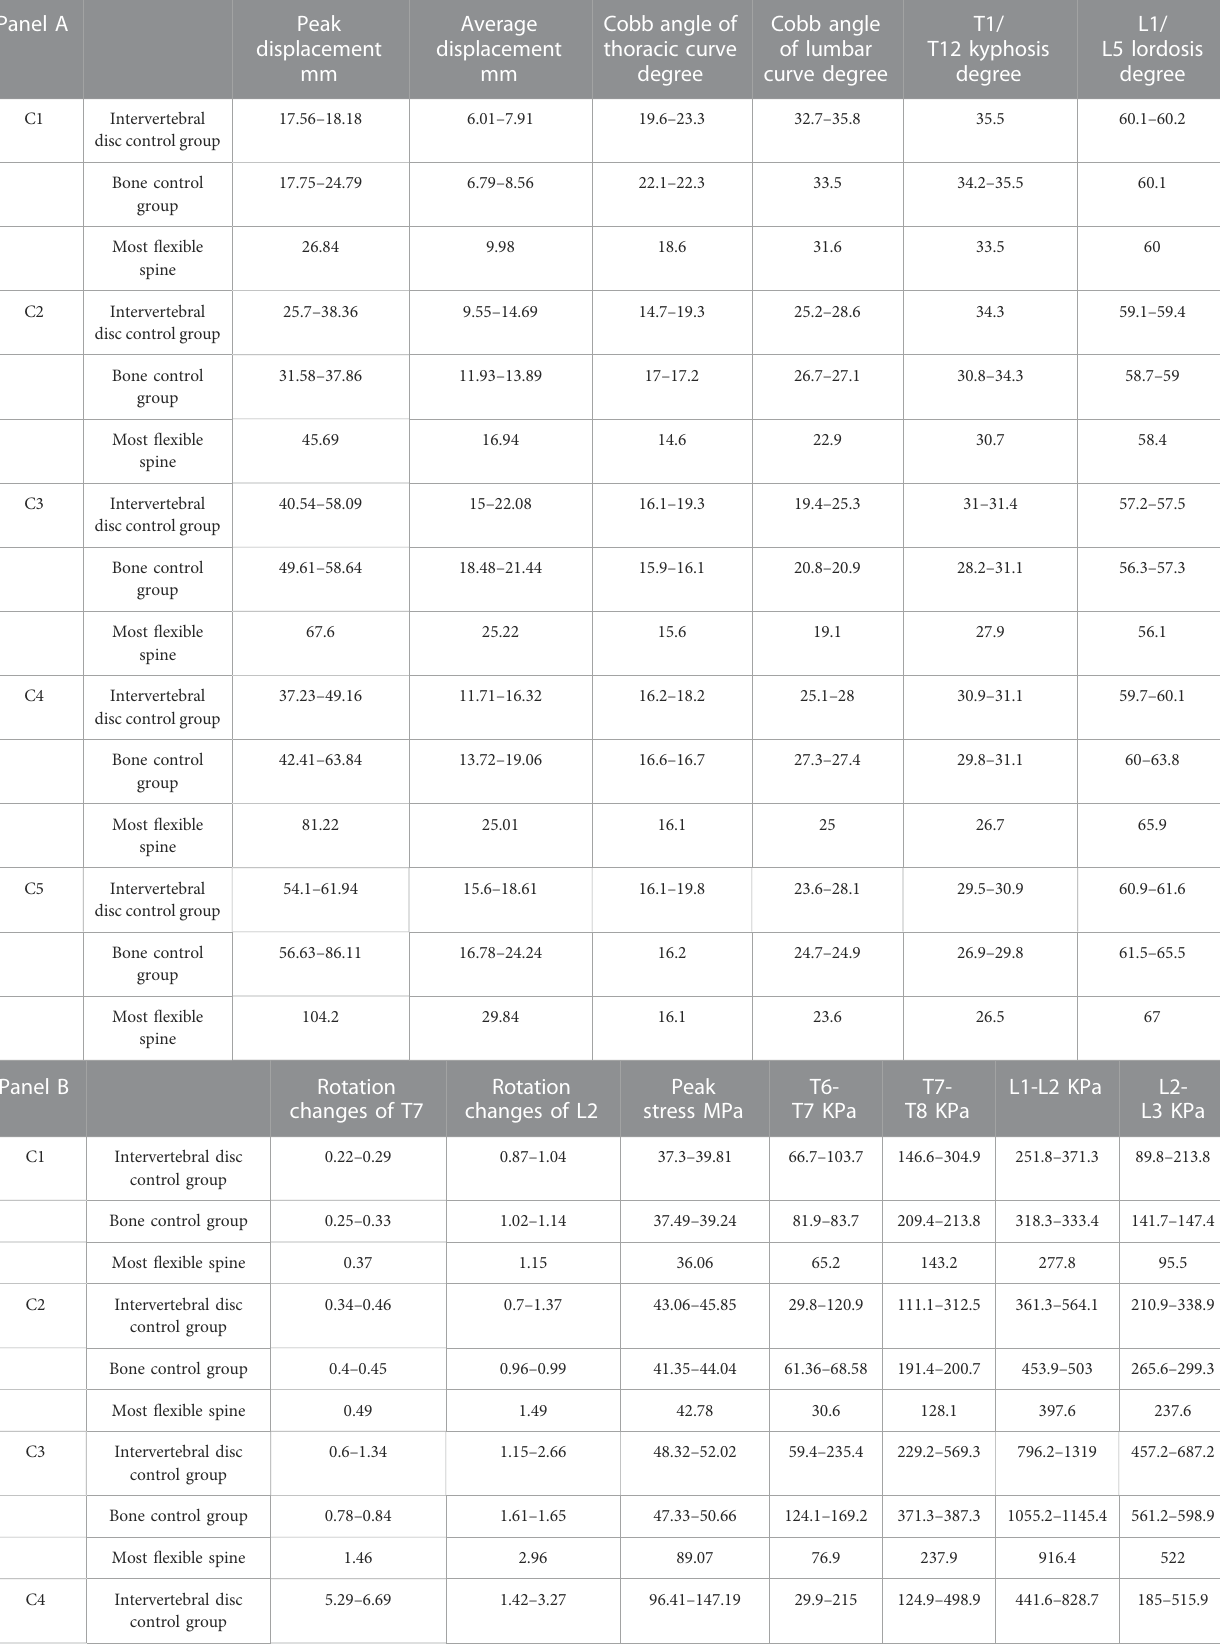
TABLE 4 Spinal parameters under different force con fi gurations and